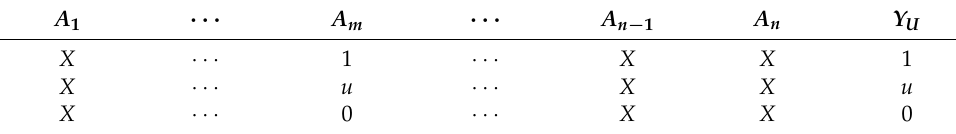
Table 7. Kleene extension of coding for activation with a set on input.